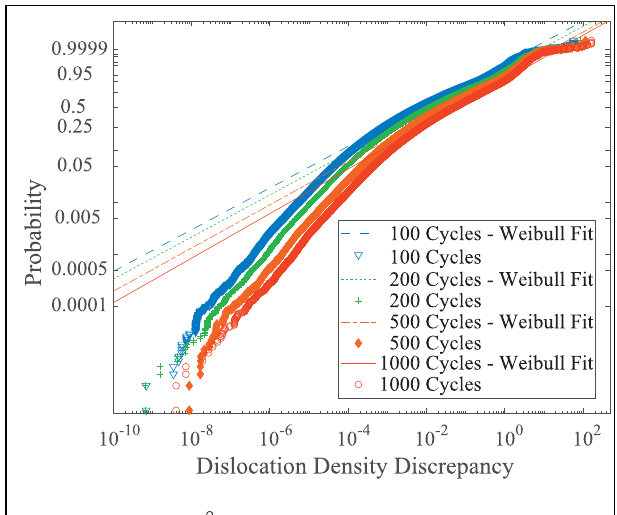
FIGURE 7 | Motion of D 3